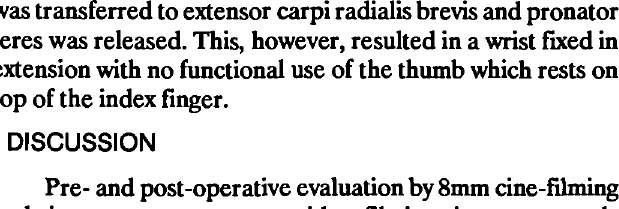
Figure 4: A pre-operative picture showing marked wrist flexion and finger extension. The thumb is not visible.